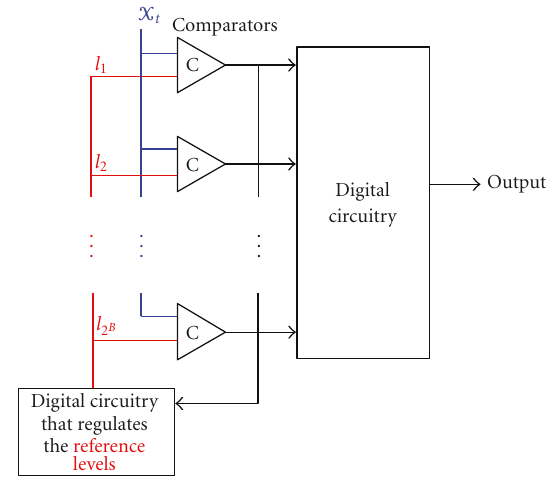
Figure 1: A conceptual design diagram of a B -bit flash-type LC